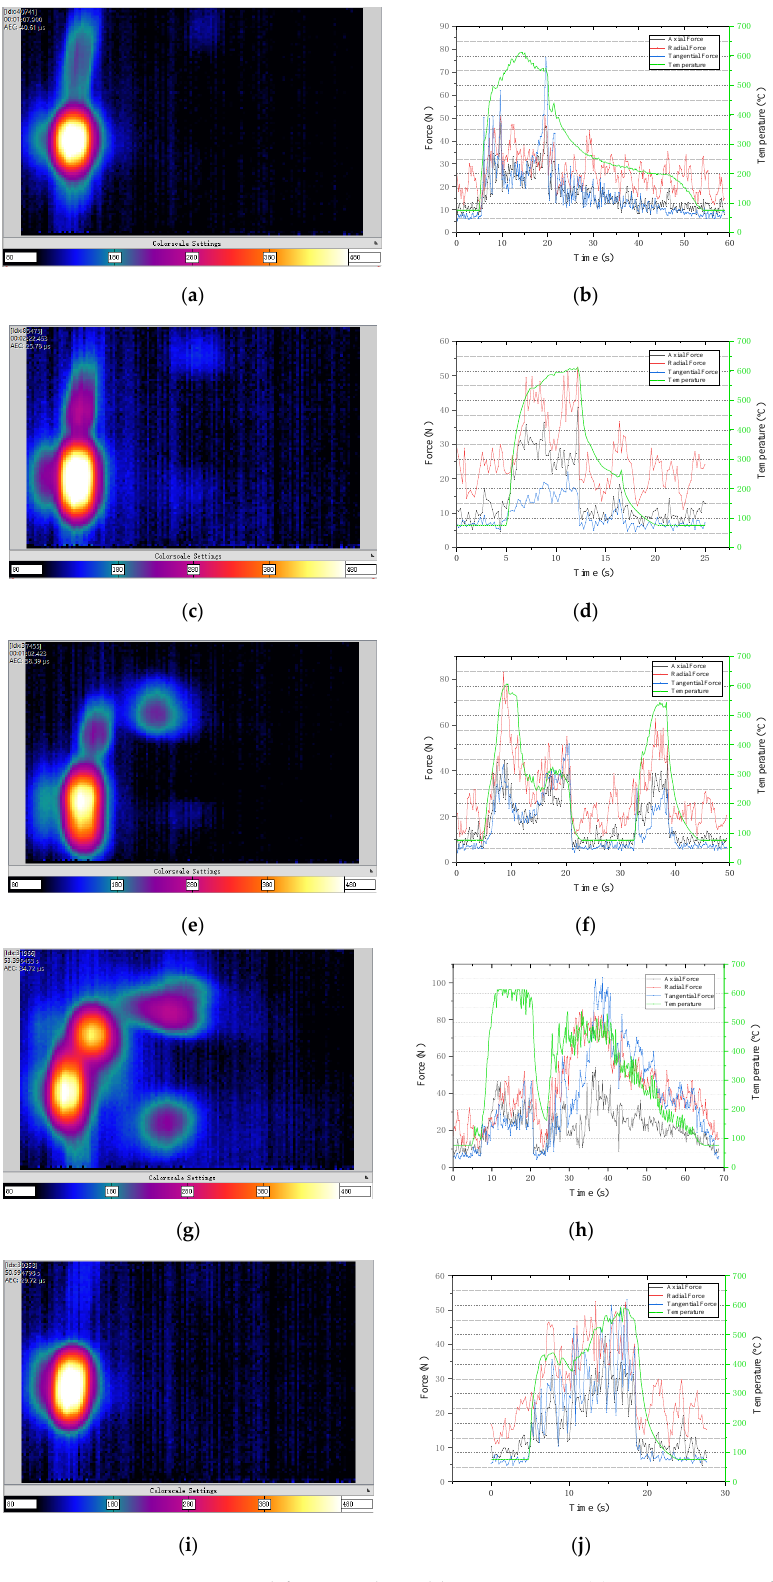
Figure 9. Temperature and force in the rubbing process. ( a ) Temperature of ra. ( b ) Temperature and force in ra. ( c ) Temperature of ax. ( d ) Temperature and force in ax. ( e ) Temperature of ra-ax. ( f ) Temperature and force in ra-ax. ( g ) Temperature of ax-ra. ( h ) Temperature and force in ax-ra. ( i ) Temperature of ra&ax. ( j ) Temperature and force in ra&ax.